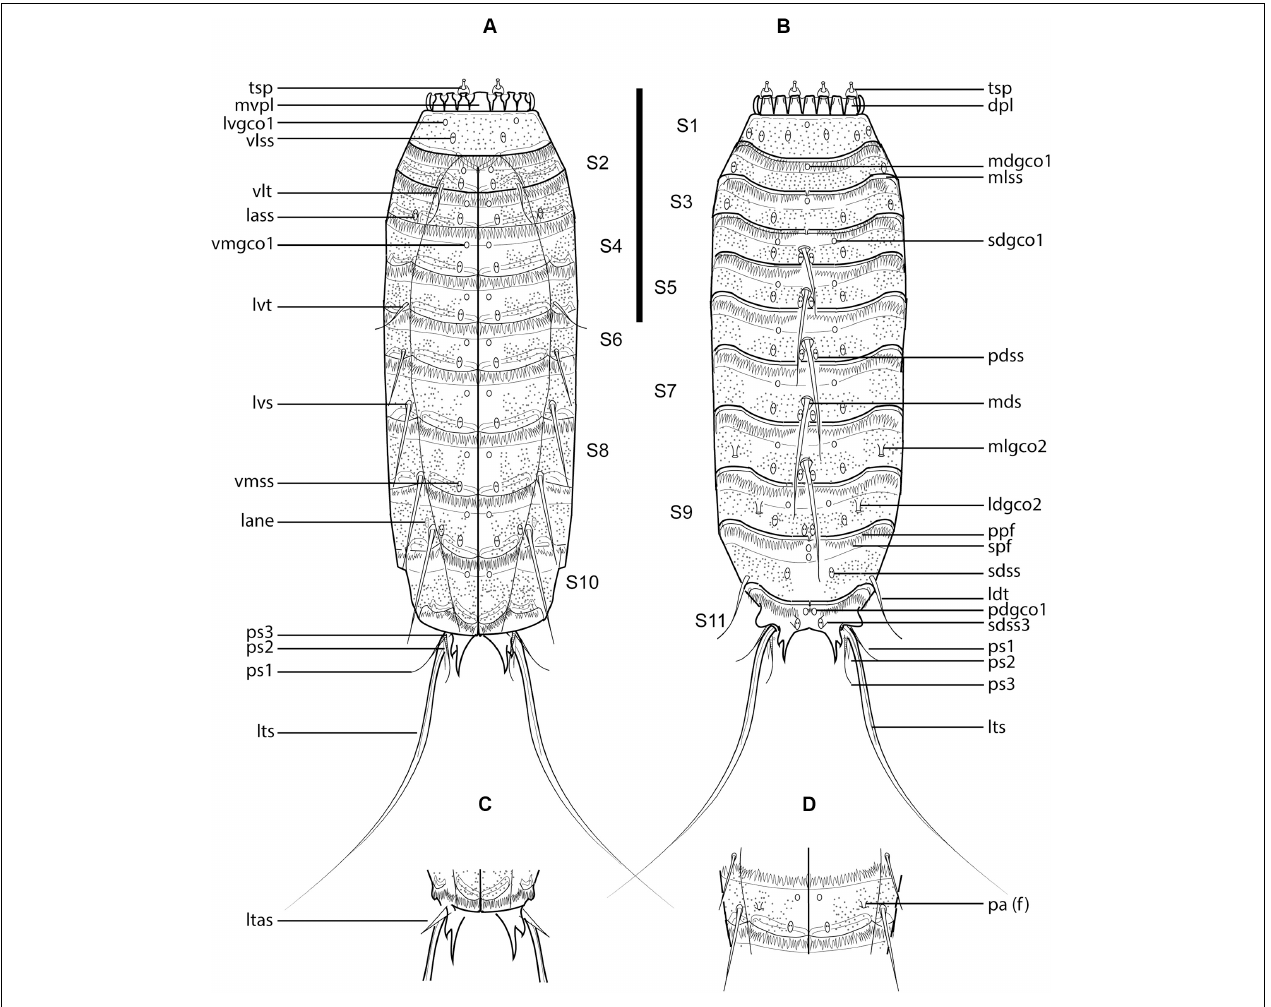
FIGURE 7 | Line art illustrations of Fissuroderes cthulhu sp. nov. (A) Male, ventral view; (B) male, dorsal view; (C) female, segments 10–11, ventral view; (D) female, segment 7, ventral view. Scale bar: 250 µ m. Abbreviations: dpl, dorsal placid; f, female condition of sexually dimorphic character; lane, lateral accessory nephridiopore; lass, lateral accessory sensory spot; ldgco2, laterodorsal type 2 glandular cell outlet; ldss, laterodorsal sensory spot; ldt, laterodorsal tube; ltas, lateral terminal accessory spine; lts, lateral terminal spine; lvgco1, lateroventral type 1 glandular cell outlet; lvs, lateroventral spine; lvt, lateroventral tube; mdgco1, middorsal type 1 glandular cell outlet; mds, middorsal spine; mlgco2, midlateral type 2 glandular cell outlet; mlss, midlateral sensory spot; mvpl, midventral placid; pa, papilla; pdgco1, paradorsal type 1 glandular cell outlet; pdss, paradorsal sensory spot; ppf, primary pectinate fringe; ps, penile spine (followed by number of corresponding pair); sdgco1, subdorsal type 1 glandular cell outlet; sdss, subdorsal sensory spot; sdss3, subdorsal type 3 sensory spot; spf, secondary pectinate fringe; tsp, trichoscalid plate; vlss, ventrolateral sensory spot; vlt, ventrolateral tube; vmgco1, ventromedial type 1 glandular cell outlet; vmss, ventromedial sensory